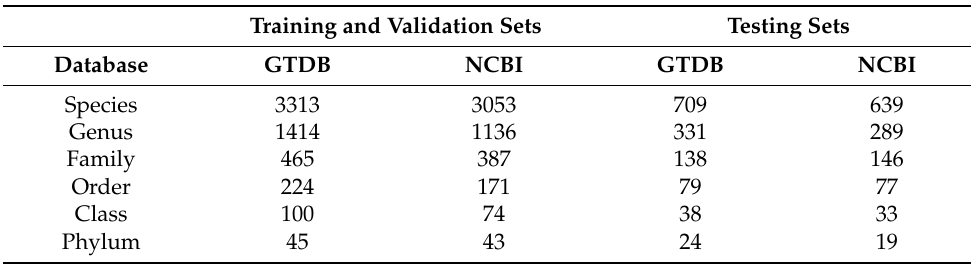
Table 1. Taxonomic distribution of training/validation and testing datasets based on the GTDB or NCBI taxonomy databases.